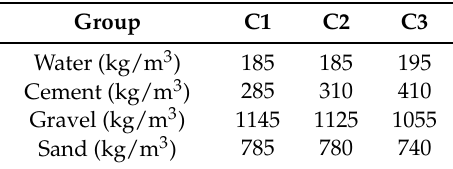
Table 1. Material compositions of